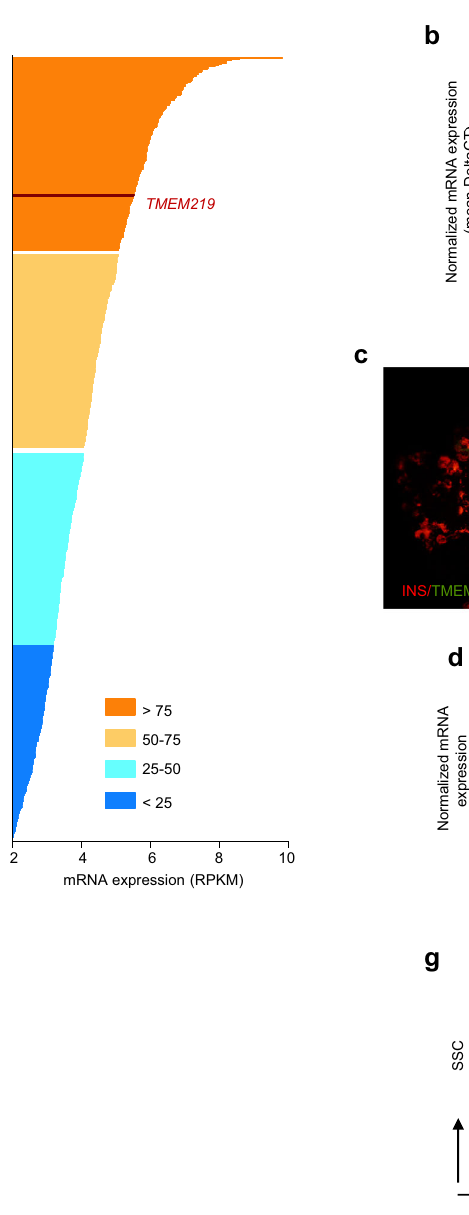
detrimental effect is evident mainly in insulin-positive cells (Fig. 3b, c, d, e, f). A transcriptome pro fi ling conducted on whole islets showed a marked upregulation of pro-apoptotic genes (i.e., CASP8 , CASP9 , TP53BP2 , TNFSF10 , FAS ) in IGFBP3-challenged islets as compared to untreated islets (Fig. 3g,